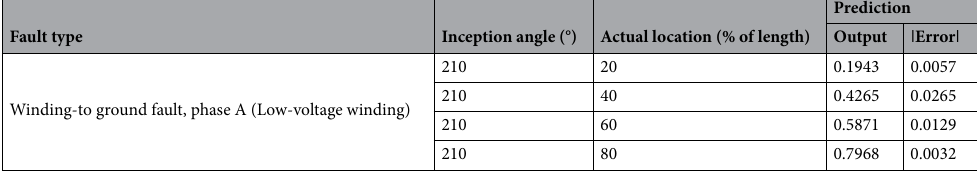
Table 8. Fault location results for phase A to ground faults at various locations on low-voltage